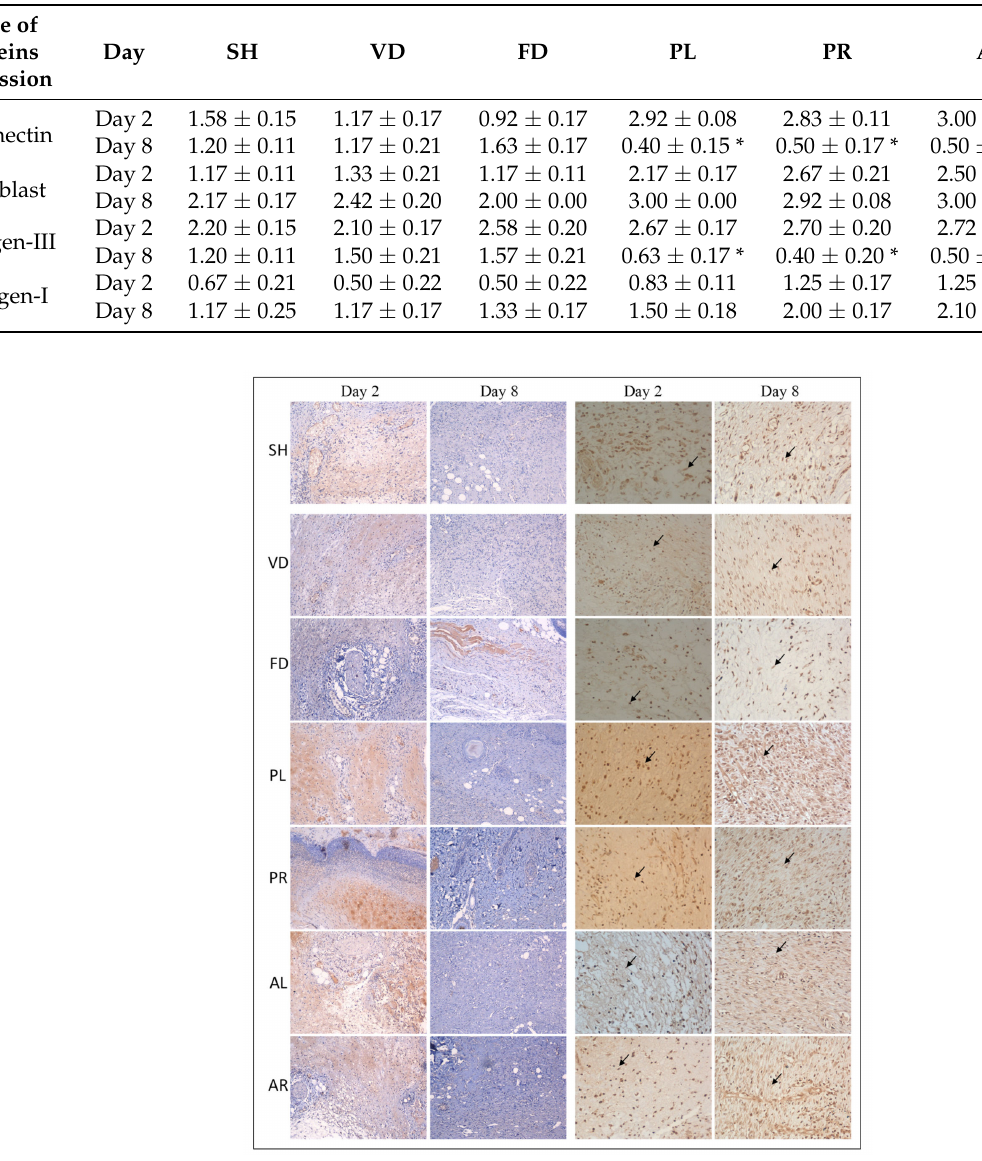
Figure 6. Photomicrographs of wounded skin tissue immunostained with an antibody against fibronectin (10 × magnification) and fibroblast (20 × magnification) in seven male rat experimental groups: SH, VD, FD, PL, PR, AL, and AR. Brown staining in the first and second columns indicates fibronectin contents, and arrows in the third and fourth columns indicate fibroblast cells. SH: sham control group (without treatment); VD: treated with vehicle (Cetomacrogol ointment); FD: treated with flavine (Acriflavine 0.1%); PL: treated with 1.0% concentration of MPvp leaves extract; PR: treated with 1.0% concentration of MPvp stem roots extract; AL: treated with 2.0% concentration of MPva leaves extract; AR: treated with 2.0% concentration of MPva stem roots extract. Bar scale: 50 µ